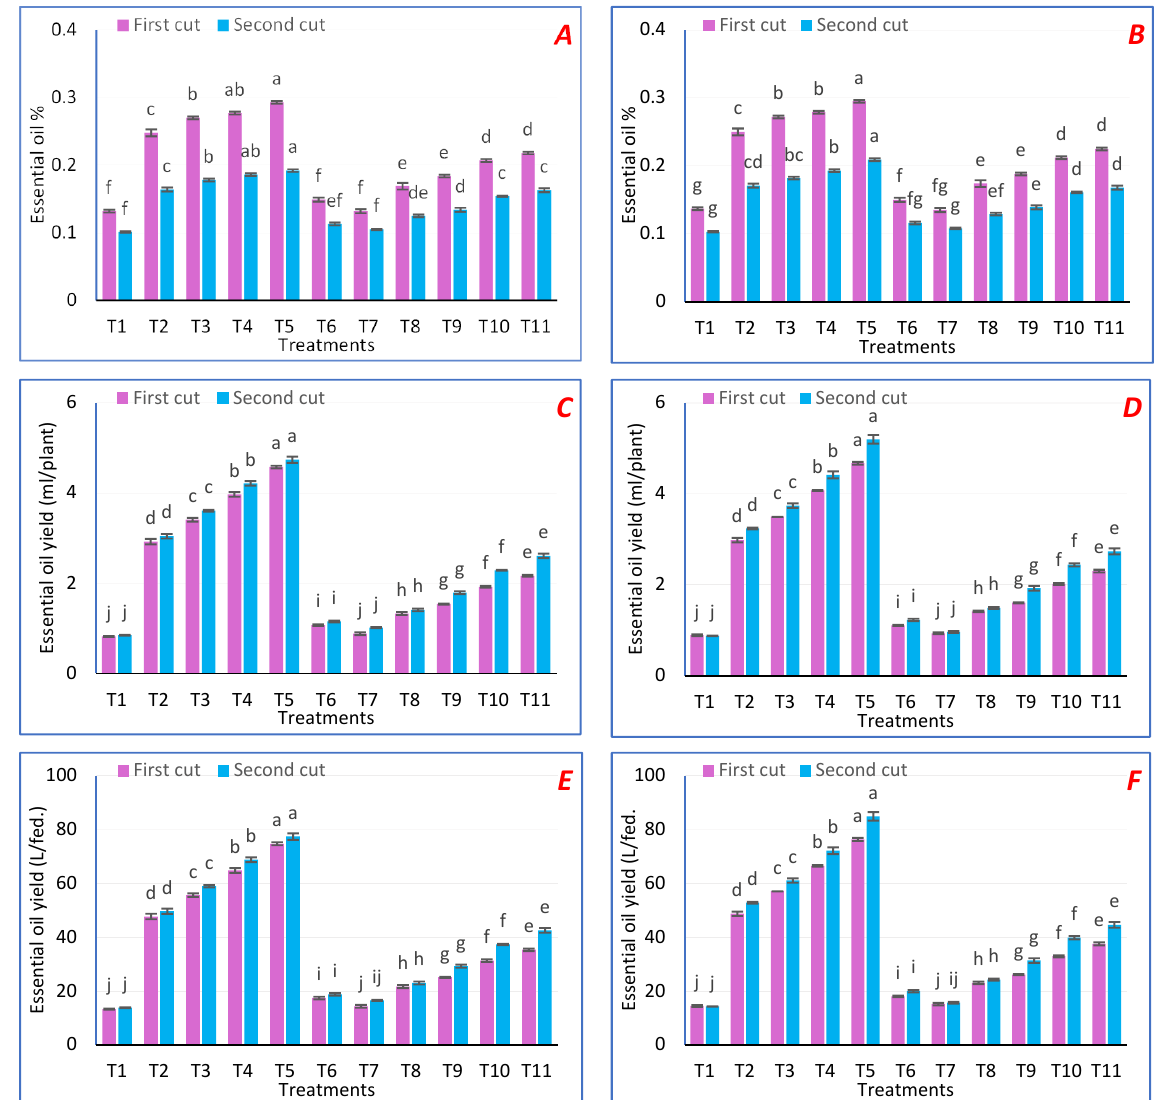
Figure 2. Effect of iron (nano, sulfate, and chelated) foliar spray on EO oil yield of Sweet Scented geranium during experimental seasons. ( A ) EO % in two cuts of the 1st season, ( B ) EO % in two cuts of the 2nd season, ( C ) EO yield (mL/plant) in two cuts of the 1st season, ( D ) EO yield (mL/plant) in two cuts of the 2nd season, ( E ) EO yield (L/fed.) in two cuts of the 1st season, ( F ) EO yield (L/fed.) in two cuts of the 2nd season. Means of three replicates are presented with ± SE. For each parameter in the year, different letters within the column show significant differences between the treatments and control according to Tukey’s HSD test at p < 0.05. T1, T2, T3, T4, T5, T6, T7, T8, T9, T10, and T11 are control, 5 mg L − 1 Fe-NPs, 10 mg L − 1 Fe-NPs, 5 mg L − 1 Fe-NPs HA, 10 mg L − 1 Fe-NPs HA, 100 mgL − 1 FeSO 4 , 200 mgL − 1 FeSO 4 , 100 mgL − 1 EDDHA, 200 mgL − 1 EDDHA, 100 mgL − 1 EDTA, and 200 mgL − 1 EDTA, respectively.